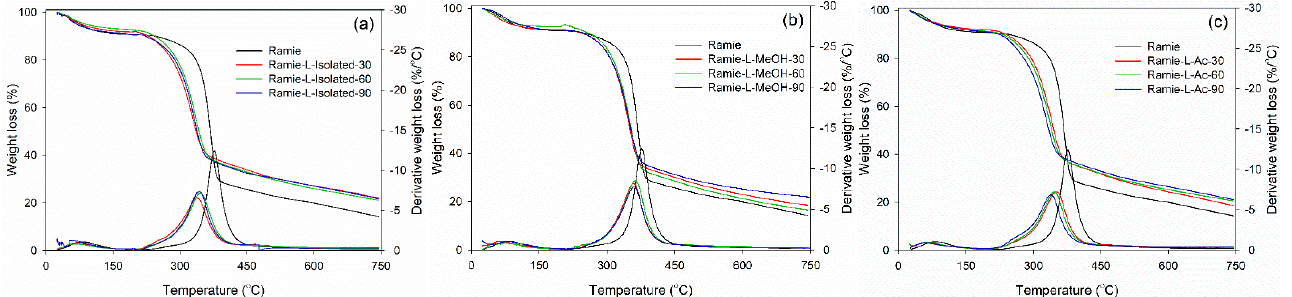
Figure 15. Thermal stability of impregnated ramie fibers determined with TGA ‐ DTG: ( a ) Ramie L ‐ Isolated, ( b ) Ramie L ‐ MeOH, and ( c ) Ramie L ‐ Ac.